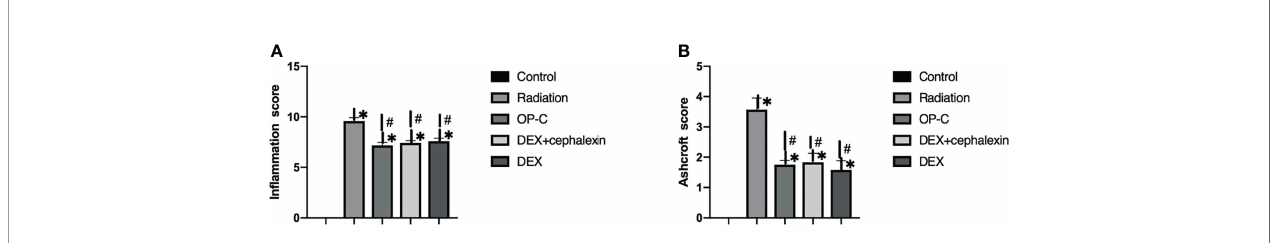
FIGURE 2 | Effects of OP-C on in fl ammation score (A) and Ashcroft score (B) in the lungs were measured in mice from the blank control, radiation only, OP-C, DEX, and DEX + cephalexin groups. The presented data are expressed as the mean ± SEM. *p < 0.05, compared with the control group. # p < 0.05, compared with the radiation-only group.